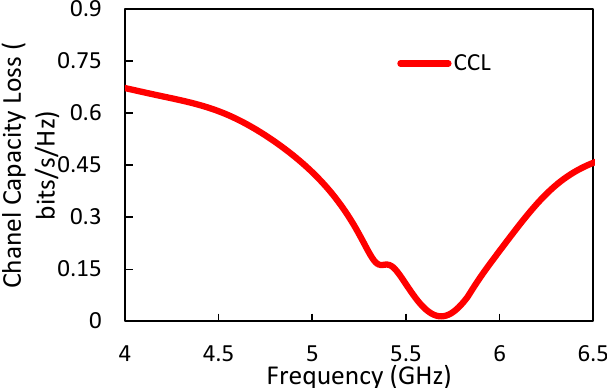
Figure 10. Chanel Capacity Loss (CCL) of the proposed